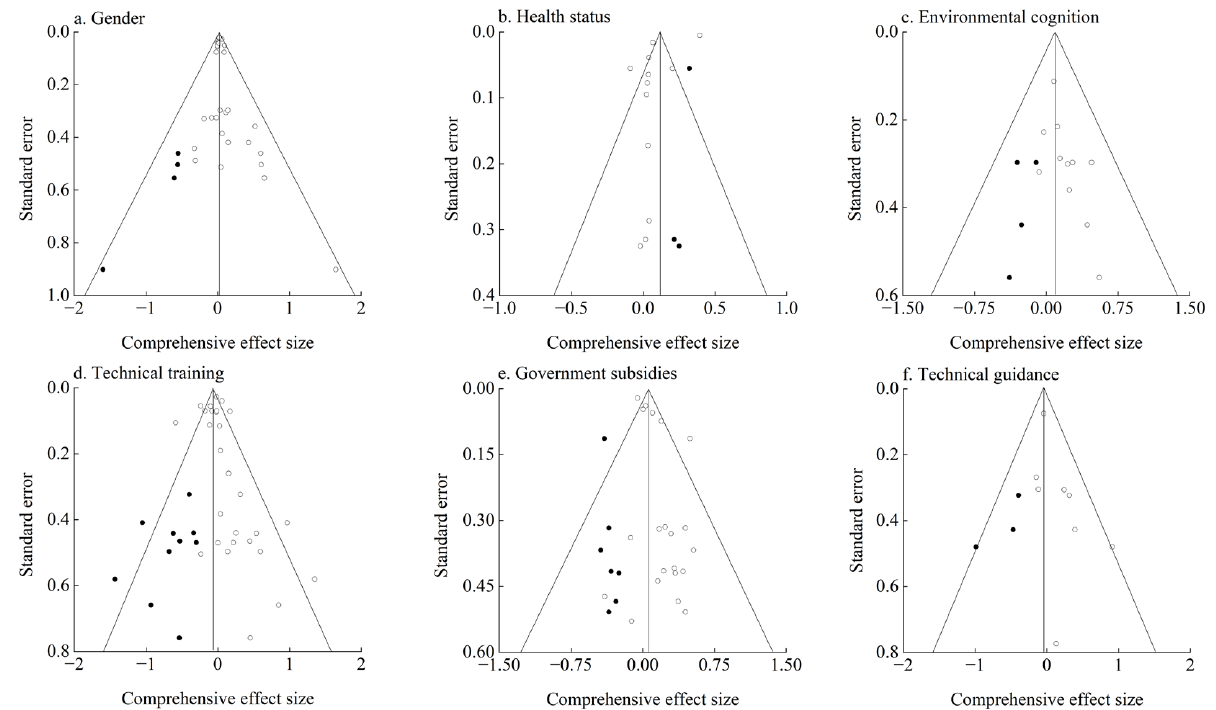
Figure 1. Funnel plot of publication bias correction. Hollow circles represent the effect sizes of previous studies, and solid circles represent non-parametric imputation values.